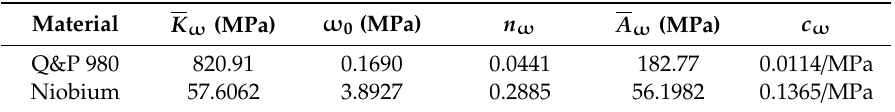
Table 10. Calibrated combined Swift–Voce type isotropic hardening coefficients for the Q&P 980 steel and niobium sheet.